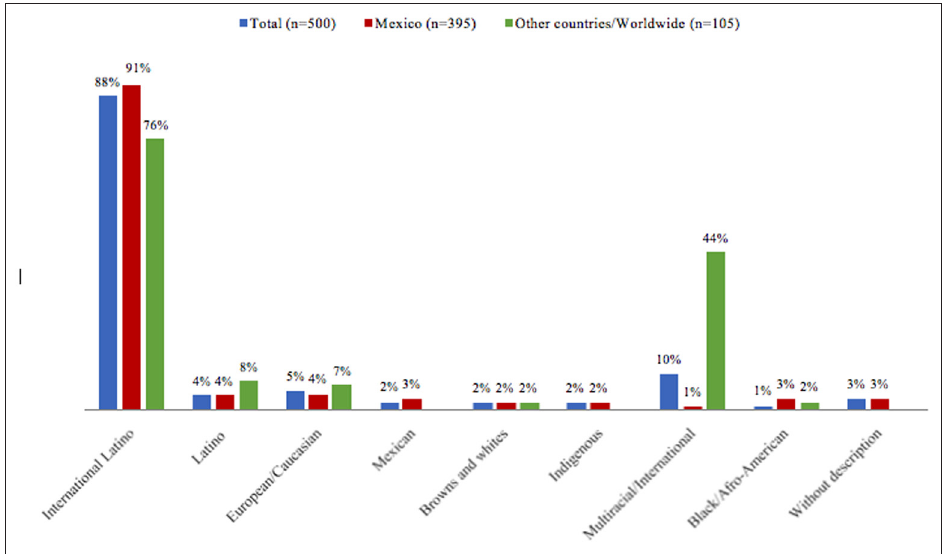
Figure 1: Requested phenotypes for advertising projects cast in Mexico. Source: Own